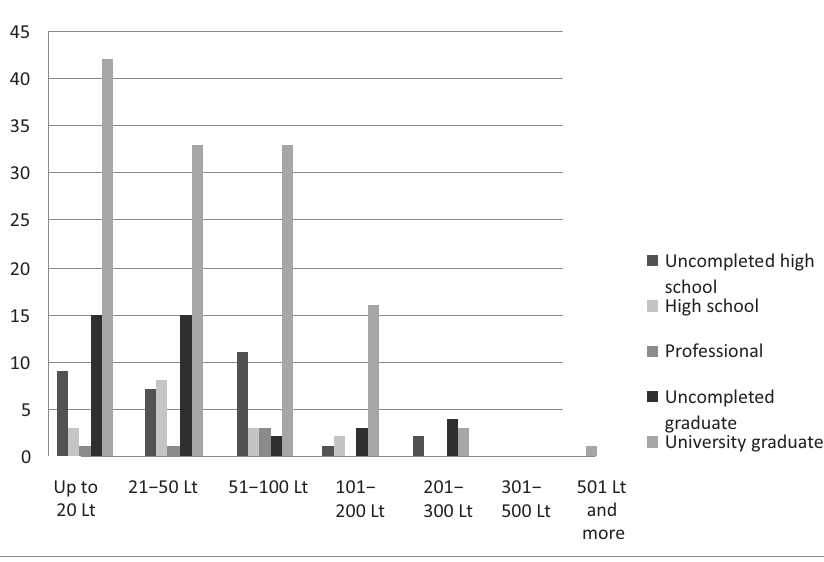
Fig. 22. Correlation between expenses during the festival period and